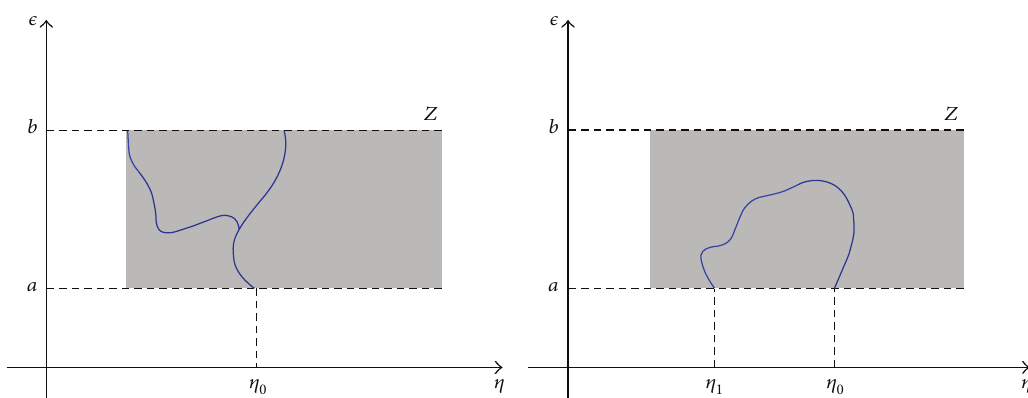
Figure 1: Graphic of the two possible options for the continuum arc which contains the point (𝜂 0 , 𝑎) in the Leray-Schauder Continuation Theorem for real analytical